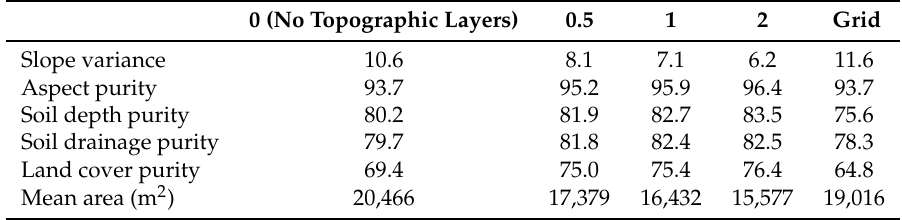
Figure 4. Image-segment boundaries (in red) overlaid on the curvature of the DEM at 10 m resolution ( left ) and the orthophoto from the Walloon Region ( right , copyright SPW 2015). The images at the top ( a , b ) display the segmentation with the topographic bands (weight of 1); the images at the bottom ( c , d ) display the segmentation without the topographic bands. The green rectangle highlights an area where the land use boundaries follow the topography. Table 2. Homogeneity of the subset of image-segments with a slope greater than 15 percent. The grid is composed of squares with the same area as the average of image-segments. Large purity values and low average of slope variance indicate a good